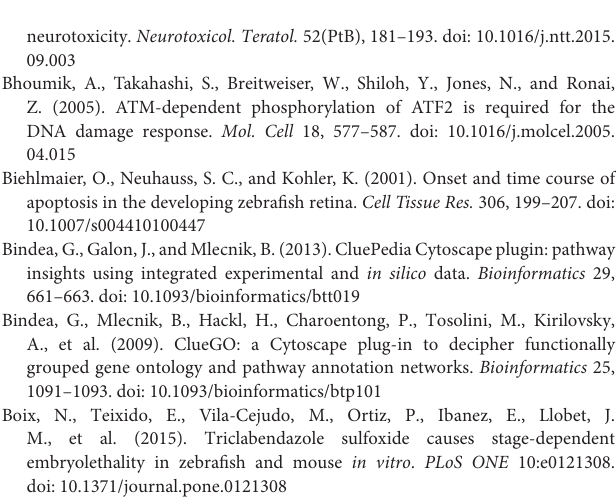
Figure S1 | ABZ and NCZ but not BBC caused developmental toxicity in the zebrafish retina. (A) Zebrafish were treated with 0.03 µ M ABZ, 0.15 µ M NCZ, or 0.3 µ M BBC from 2 to 5dpf at the indicated concentration. Zebrafish were stained with ZMA462 and the retinas were imaged in vivo . Scale bar: 50 µ m. (B) Quantitative analysis of the developmental toxicity of benzimidazole compounds in the zebrafish retina. The shape of the IPL in each zebrafish was quantified using the shape factor. n = 8 for control, n = 4 for ABZ, n = 3 for NCZ and BBC, ∗ p < 0.05 compared with control. Figure S2 | Protein interaction networks associated with the ATM signaling pathway at 12, 24, and 36h exposure to 0.3 µ M MBZ. The protein interaction networks associated with the ATM signaling pathway at 12, 24, and 36h exposure to 0.3 µ M MBZ are shown in A , B , and C , respectively. Figure S3 | Identification of ATF2 as a TF potentially regulating the DEGs in zebrafish exposed to 0.3 µ M MBZ for 12, 24, or 36h. The networks between ATF2 and target genes at 12, 24, and 36h exposure to 0.3 µ M MBZ are shown in A , B and C , respectively. Table S1 | Genes dysregulated in zebrafish exposed to 0.3 µ M MBZ. (S1-1) 12h exposure; (S1-2) 24h exposure; (S1-3) 36h exposure. Table S2 | Pathways significantly enriched in the genes dysregulated in zebrafish exposed to 0.3 µ M MBZ. (S2-1) 12h exposure; (S2-2) 24h exposure; (S2-3) 36h exposure; (S2-4) Common pathways significantly enriched in the genes dysregulated in zebrafish 549 exposed to MBZ for 12, 24, and 36h. Table S3 | BioCarta pathways significantly related to the genes dysregulated in zebrafish exposed to 0.3 µ M MBZ. (S3-1) 12h exposure; (S3-2) 24h exposure; (S3-3) 36h exposure; (S3-4) Common BioCarta pathways significantly related to the genes dysregulated in zebrafish 557 exposed to MBZ for 12, 24, and 36h. Table S4 | TFs potentially regulating the differentially expressed genes in zebrafish exposed to 0.3 µ M MBZ. (S4-1) 12h exposure; (S4-2) 24h exposure; (S4-3) 36h